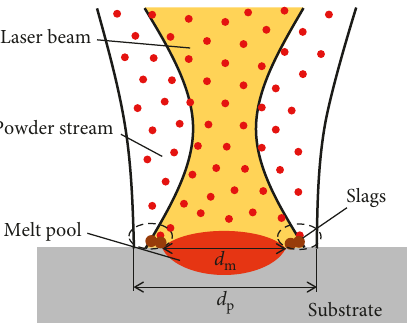
Figure 13: Schematic diagram of the formation of slag